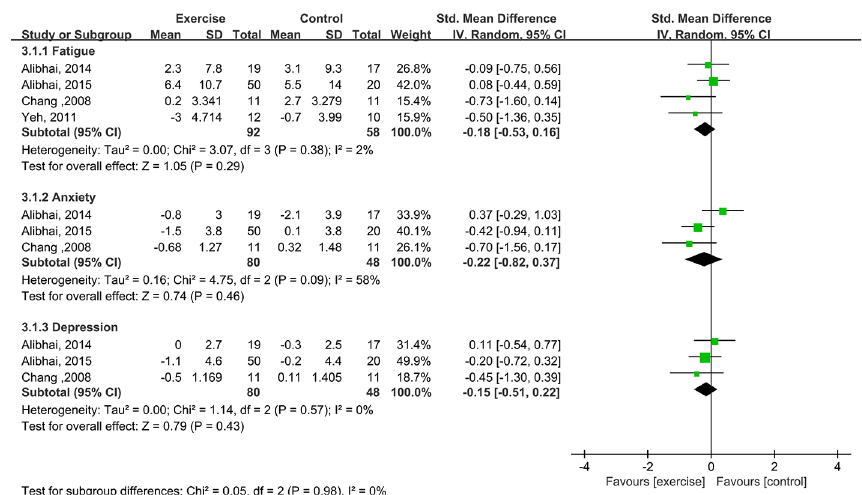
Fig 6. Forest plot comparing the changes in fatigue, anxiety and depression between exercise and control groups.